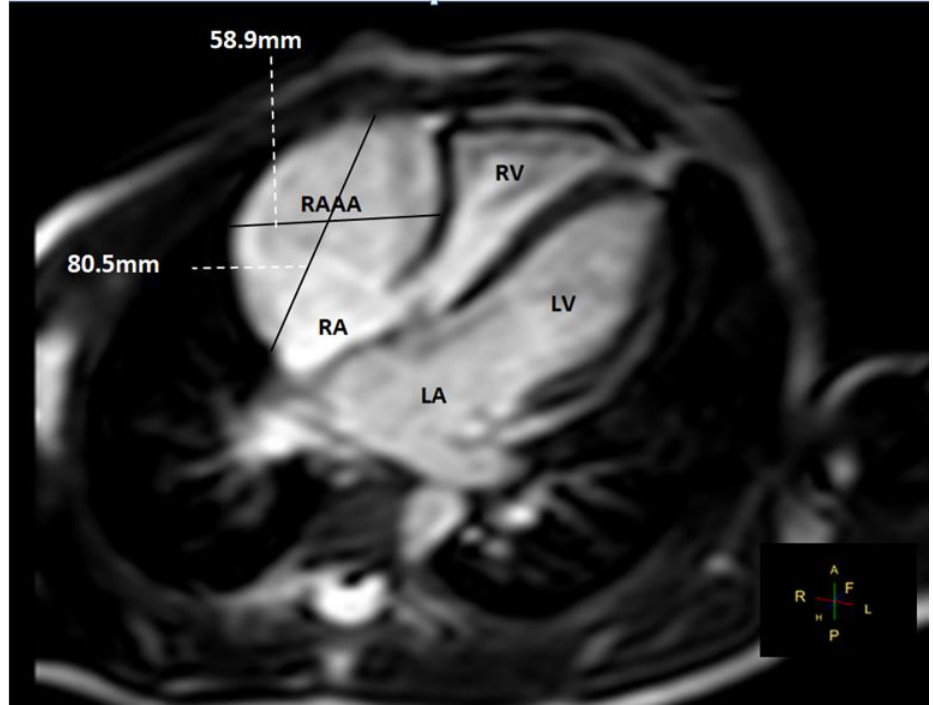
Figure 10. MRI in the same child eight years later. The initial gigantic aneurismal dilatation of the RAAA had diameters of 80 mm × 59 mm, reaching a total volume of 110 mL.